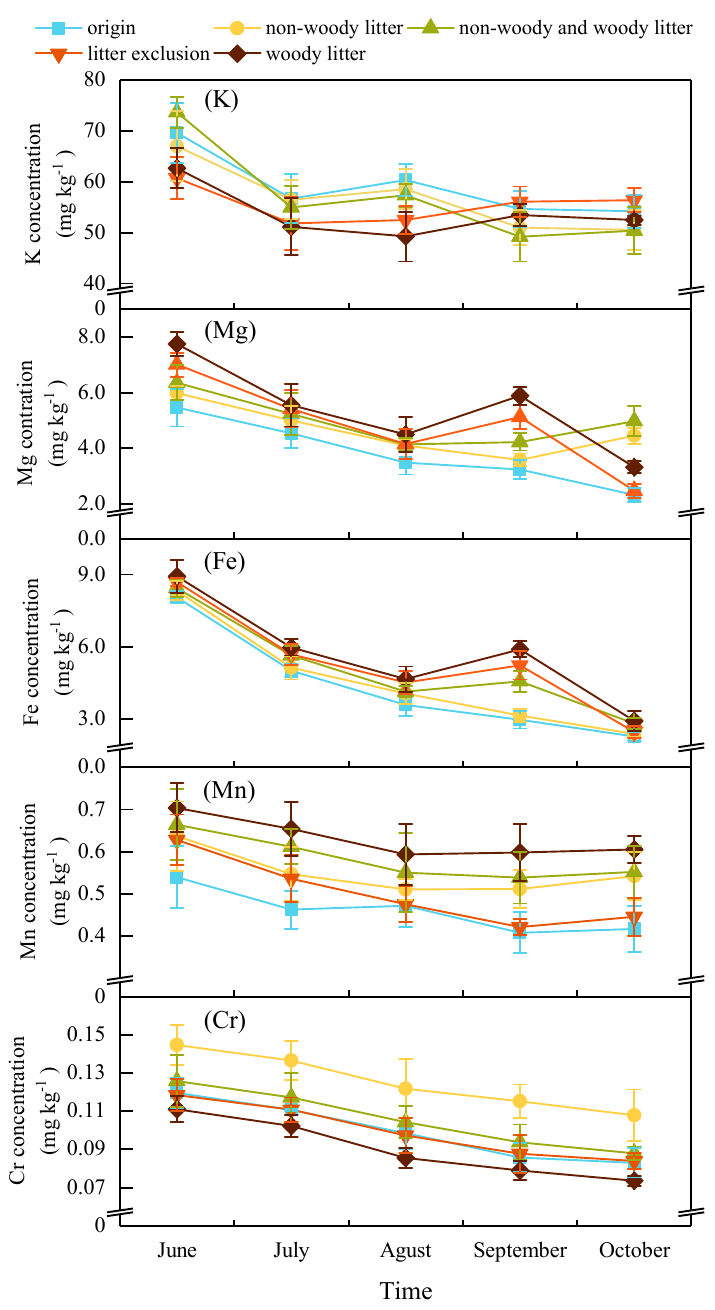
Figure 5. The K, Mg, Fe, Mn and Cr concentration of the sediment in the stream with different plant litter input conditions.